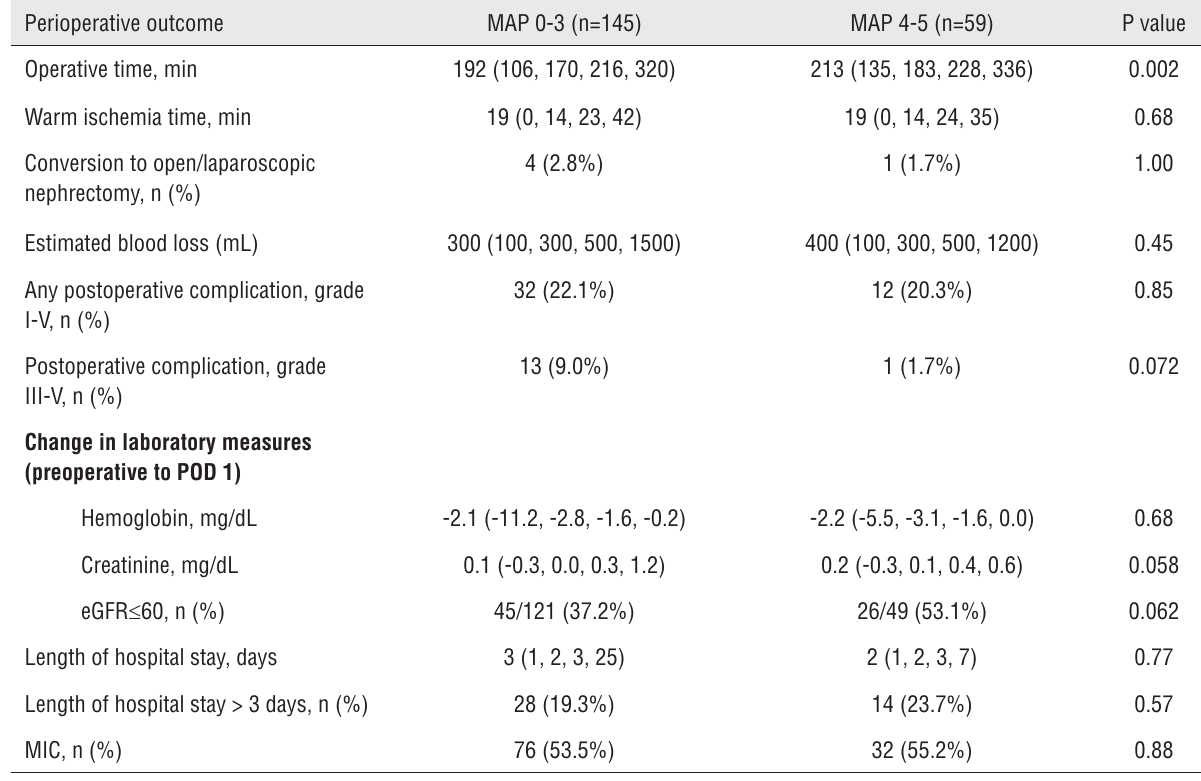
Table 4 - Perioperative Outcomes according to the Mayo Adhesive Probability